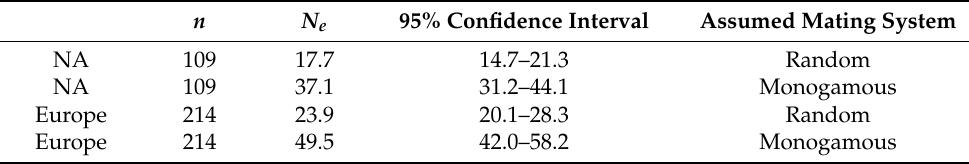
Table 3. Estimates of contemporary effective population size ( N e ) based on 14 microsatellites amplified in the NA population of APD—(this study), and compared to the European captive population [18], which was genotyped at 9 of the 14 microsatellite loci used in the current study. N e was estimated in both populations using the linkage disequilibrium method [68], with a 95% confidence interval obtained through nonparametric jackknifing